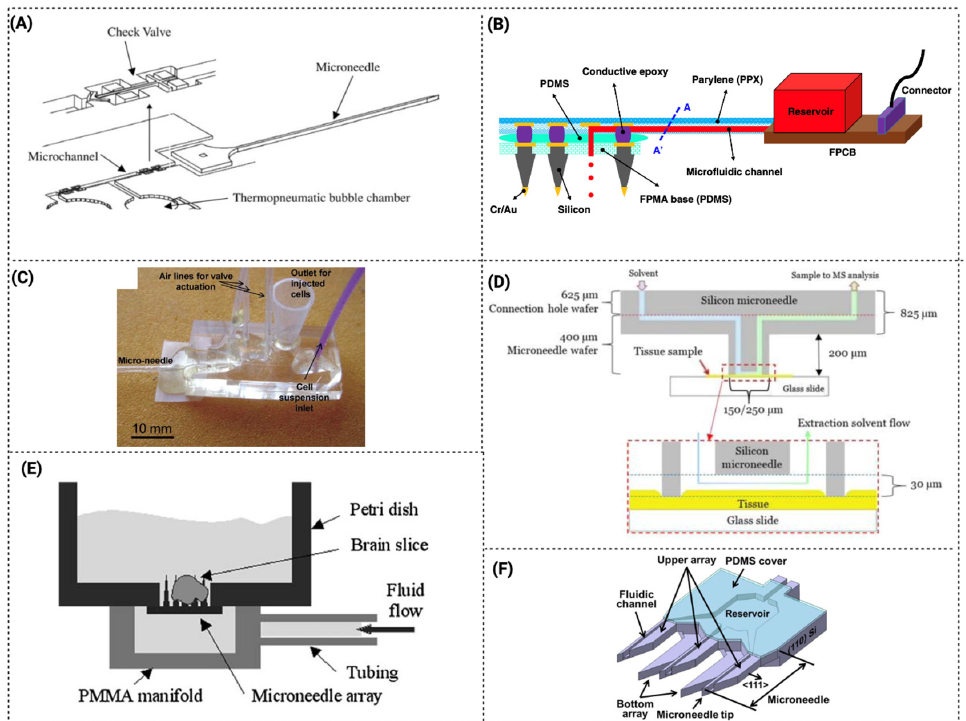
Figure 5. Schematic compilation of MN microfluidic devices for drug delivery and microinjection. ( A ) Schematic of an integrated micropump/microneedle device. The top shows a closeup of a planar free floating directional microvalve. Reprinted from [70]. Copyright © 2023, with permission from Springer. ( B ) The flexible penetrating microelectrode array is integrated with the microfluidic interconnection cable ( µ FIC). Reprinted from [71]. Copyright © 2023, with permission from Nature. ( C ) Assembled microinjection device. Reprinted from [74]. Copyright © 2023, with permission from Royal Society of Chemistry. ( D ) Silicon microneedle structure showing the solvent injection and sample aspiration during microneedle extraction. Reprinted from [87]. Copyright © 2023, with permission from American Institute of Physics. ( E ) A photomicrograph shows the microneedle array perfusing a brain slice. The microfluidic perfusion system integrates microneedle arrays in a packaged system for fluid containment. Reprinted from [89]. Copyright © 2023, with permission from Springer. ( F ) Schematic illustration of the proposed 2D in-plane microneedle chip. Reprinted from [77]. Copyright © 2023, with permission from Springer.